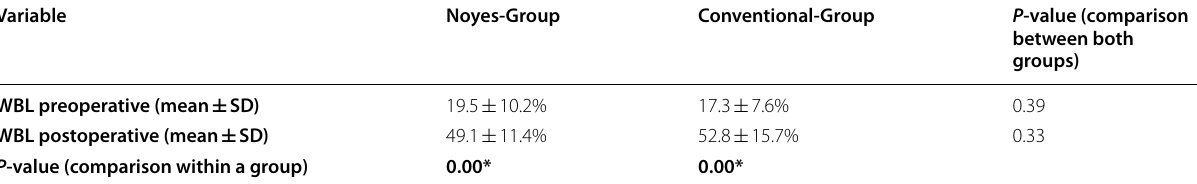
The location of the weight-bearing line (WBL) on the tibial plateau according to its medial to lateral total tibial width ratio is shown for the pre- and postoperative state. P -values are displayed for comparison of the mean WBL from the pre- to postoperative visit within a group (last row) as well as for comparison of the WBL between both groups (last column). Statistically significant values are marked by asterisks